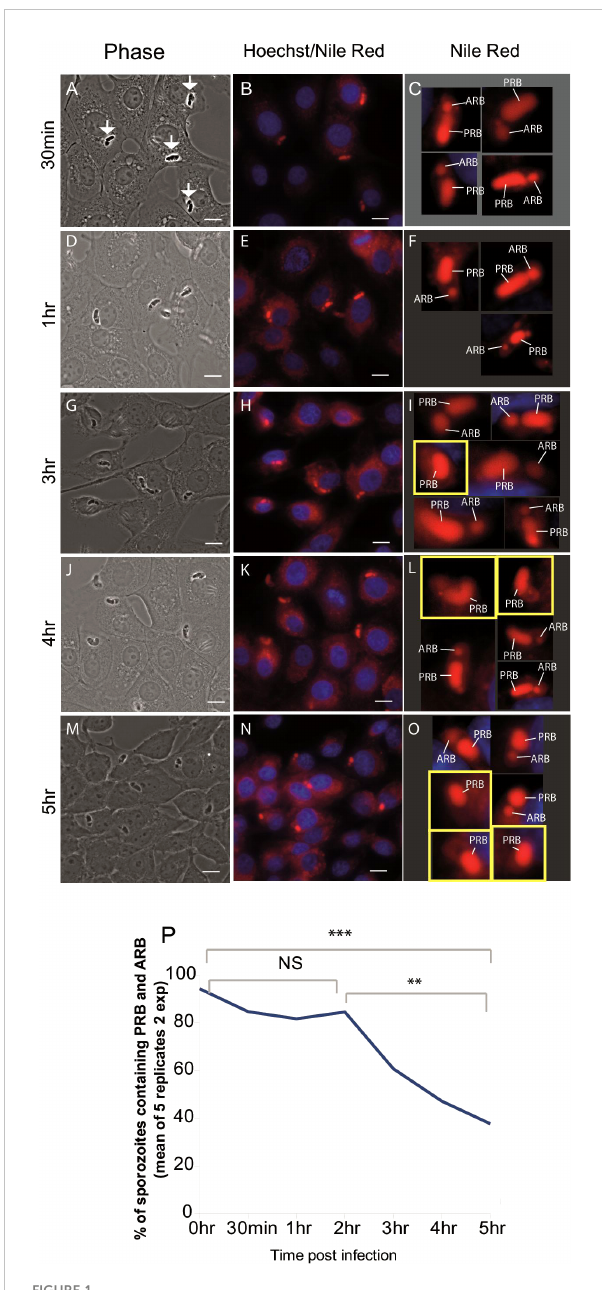
FIGURE 1 Loss of the anterior refractile body following host cell infection. Left panels (A, D, G, J, M) phase contrast light microscopy of sporozoites (arrows) within MDBK cells. Middle panels (B, E, H, K, N) Nile Red staining (red) localises to the RBant. and RBpost., Hoechst staining localises to host cell nuclei (blue). Right panels (C, F, I, L, O) magni fi cation of single sporozoites visualised in the middle panels. Sporozoites containing a single refractile body are highlighted in a yellow square; (P) percentage of parasites containing both the RBant. and RBpost. from 0 hours (freshly hatched) to 5 hpi (two experiments/5 replicates) plotted to illustrate trend of RBant. reduction over the time course. Scale bars = 10 m m. **p ≤ 0.01, ***p ≤ 0.001; NS, not statistically signi fi